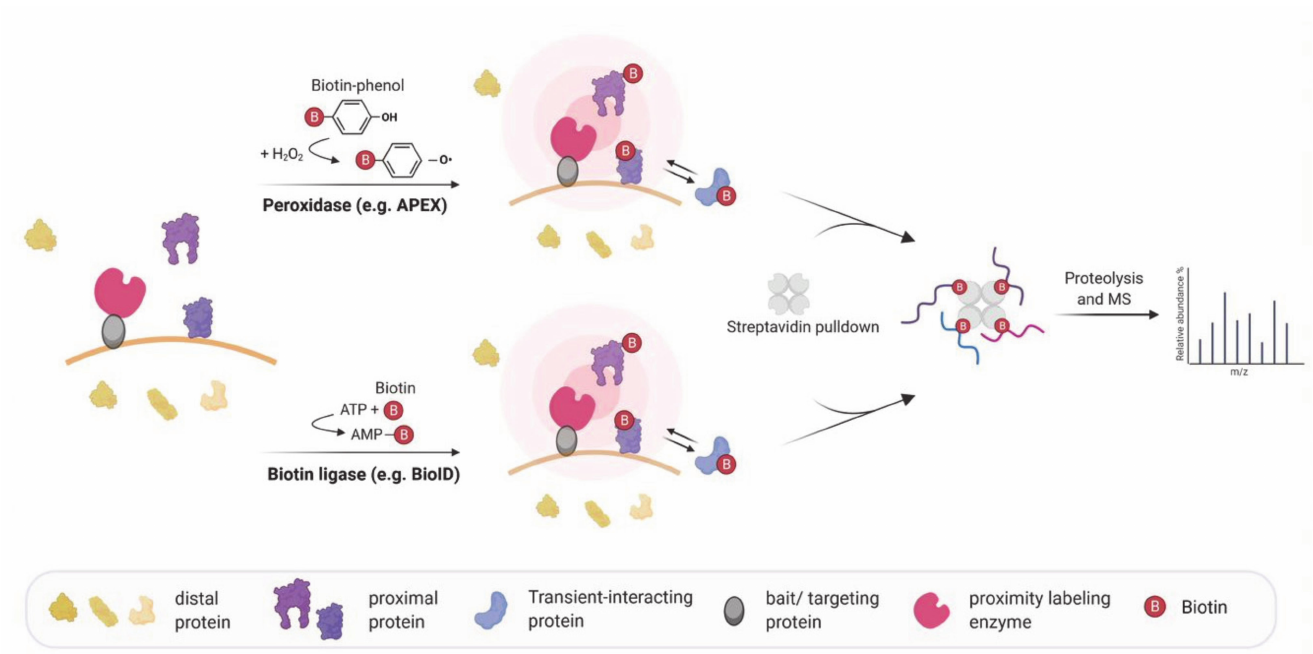
Figure 1. Schematic workflow of peroxidase and biotin ligase based in vivo proximity labeling for mapping molecular interactions. Proximity labeling enzymes fused to a targeting protein are incubated with biotin or a biotin conjugated compound and convert it to a reactive biotin intermediate. Peroxidases oxidize biotin–phenol to reactive phenoxyl radicals using hydrogen peroxide while biotin ligases utilize ATP and biotin to catalyze the formation of reactive biotin-5 (cid:48) -AMP. The biotin intermediate is released from the enzyme and covalently biotinylates proteins in the proximity but not distal proteins. After lysis, the biotinylated proteins are enriched by a streptavidin-pulldown followed by proteolysis and are analyzed by mass